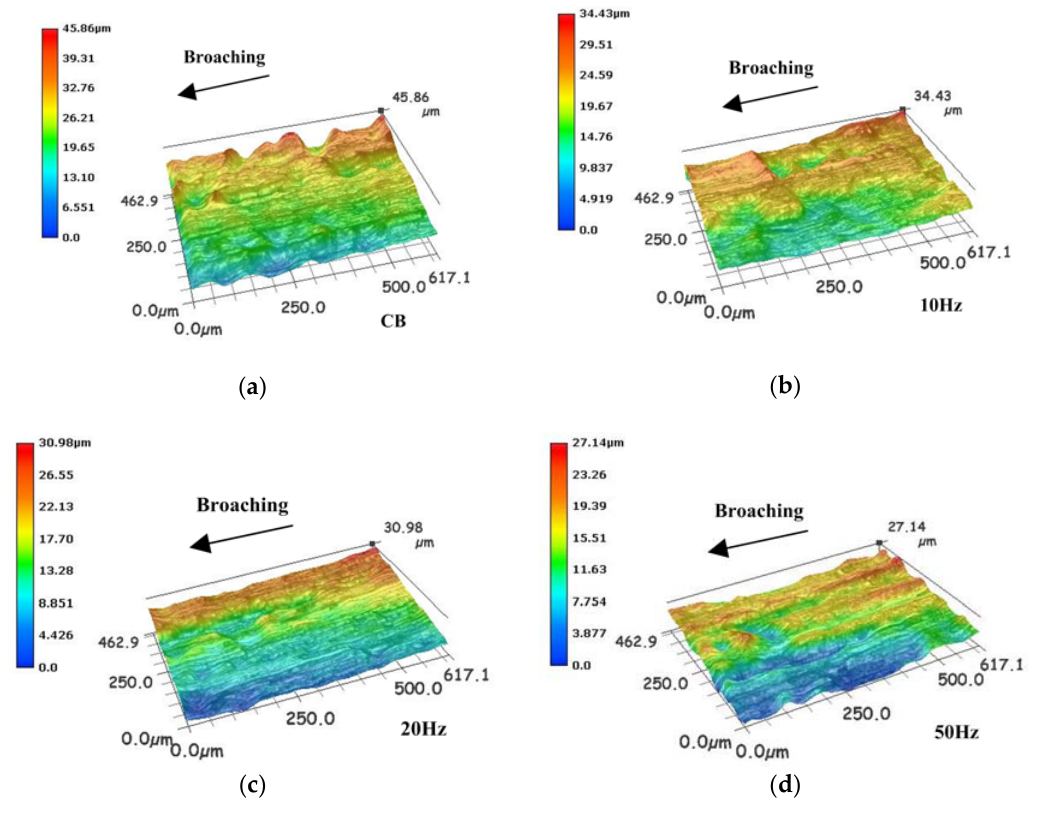
Figure 10. Workpiece surface (st) of ( a ) CB, ( b ) 10 Hz, ( c ) 20 Hz and ( d ) 50 Hz.